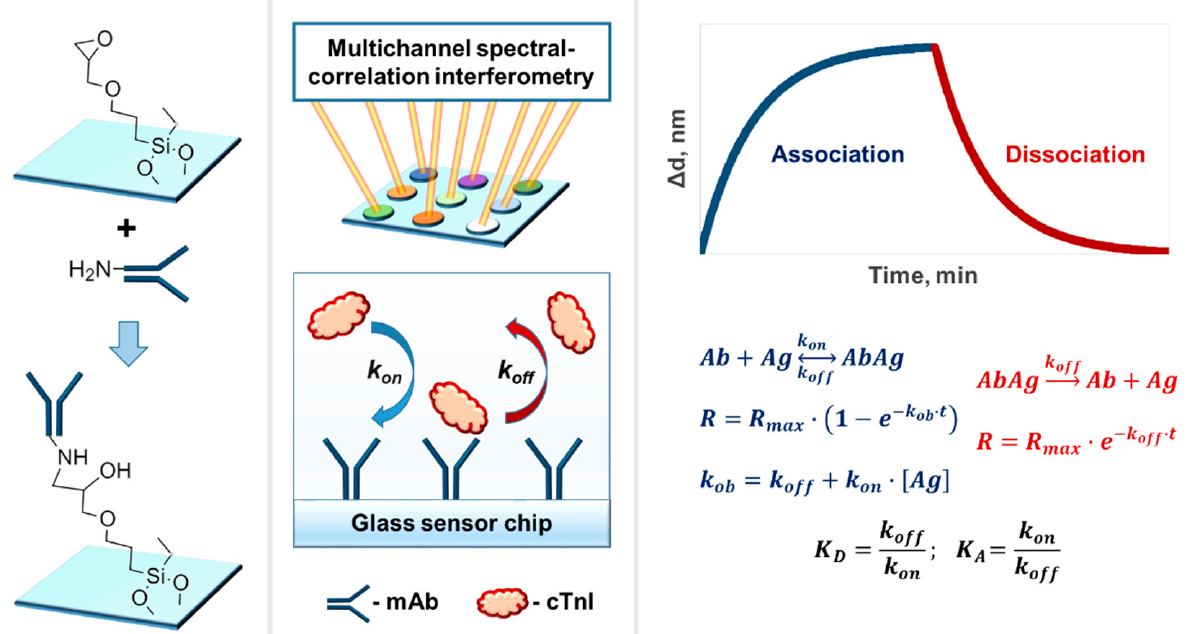
Figure 2. Experimental setup for simultaneous determination of kinetic constants of multiple monoclonal antibodies with an mSCI-biosensor.